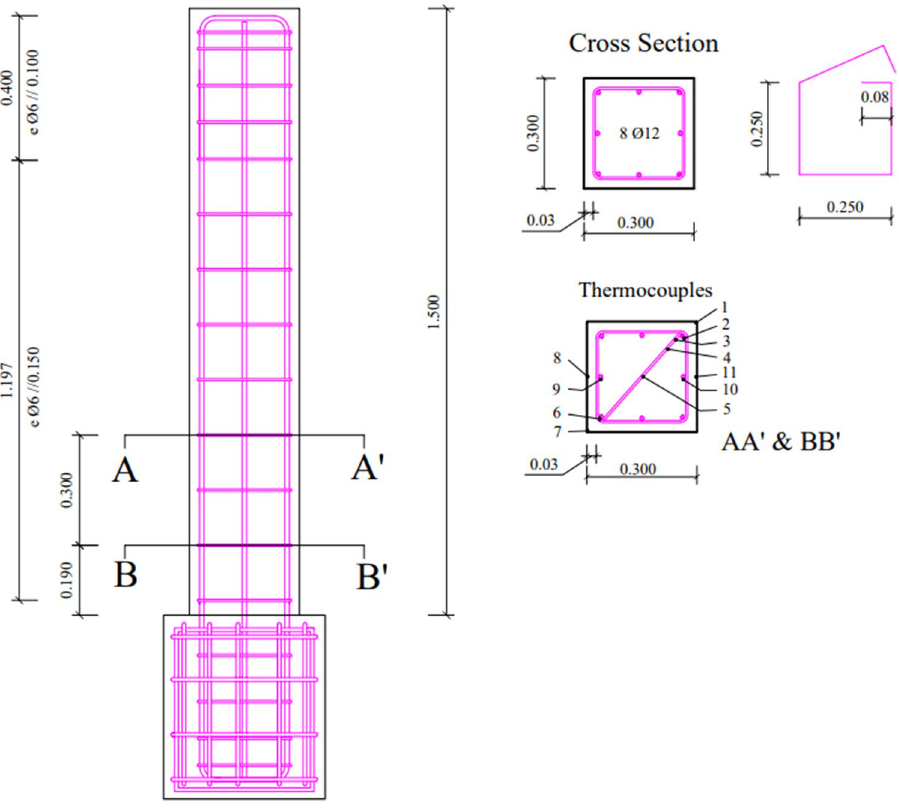
Figure 3. Details of specimens.